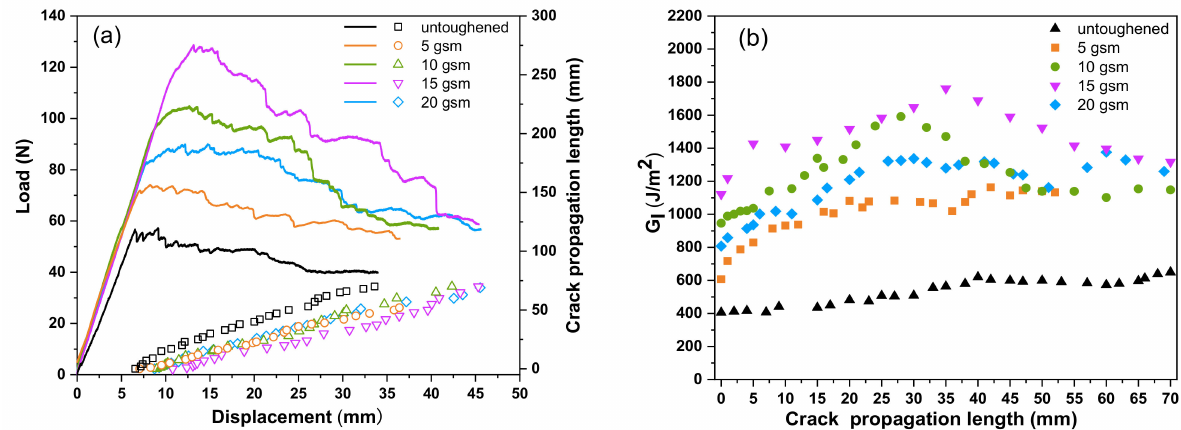
Figure 5. DCB test results of untoughened laminate and the laminates interleaved with different areal densities of TPPI fiber veils: ( a ) Load–displacement curves and crack propagation length–displacement curves, as well as ( b ) the corresponding R-curves.